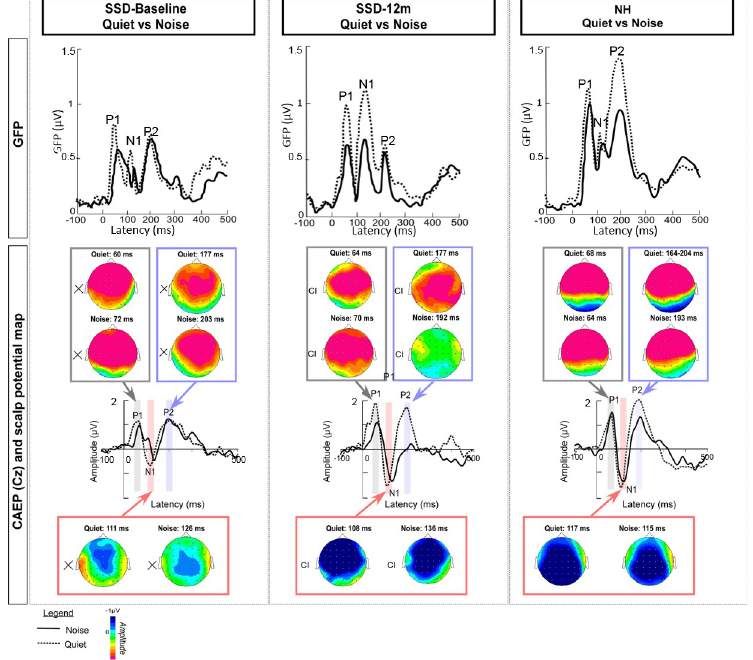
Fig 2. Mean surface recordings for SSD-CI participants at baseline (left panels) and at 12m post-activation (middle panels), and for NH participants (right panels) in quiet (dotted line) and in noise (solid line). The top panels show mean global field power (GFP). The lower panels show CAEPs at Cz, with topographic distributions (top view) of mean average referenced to surface responses at P1, N1 and P2 peak